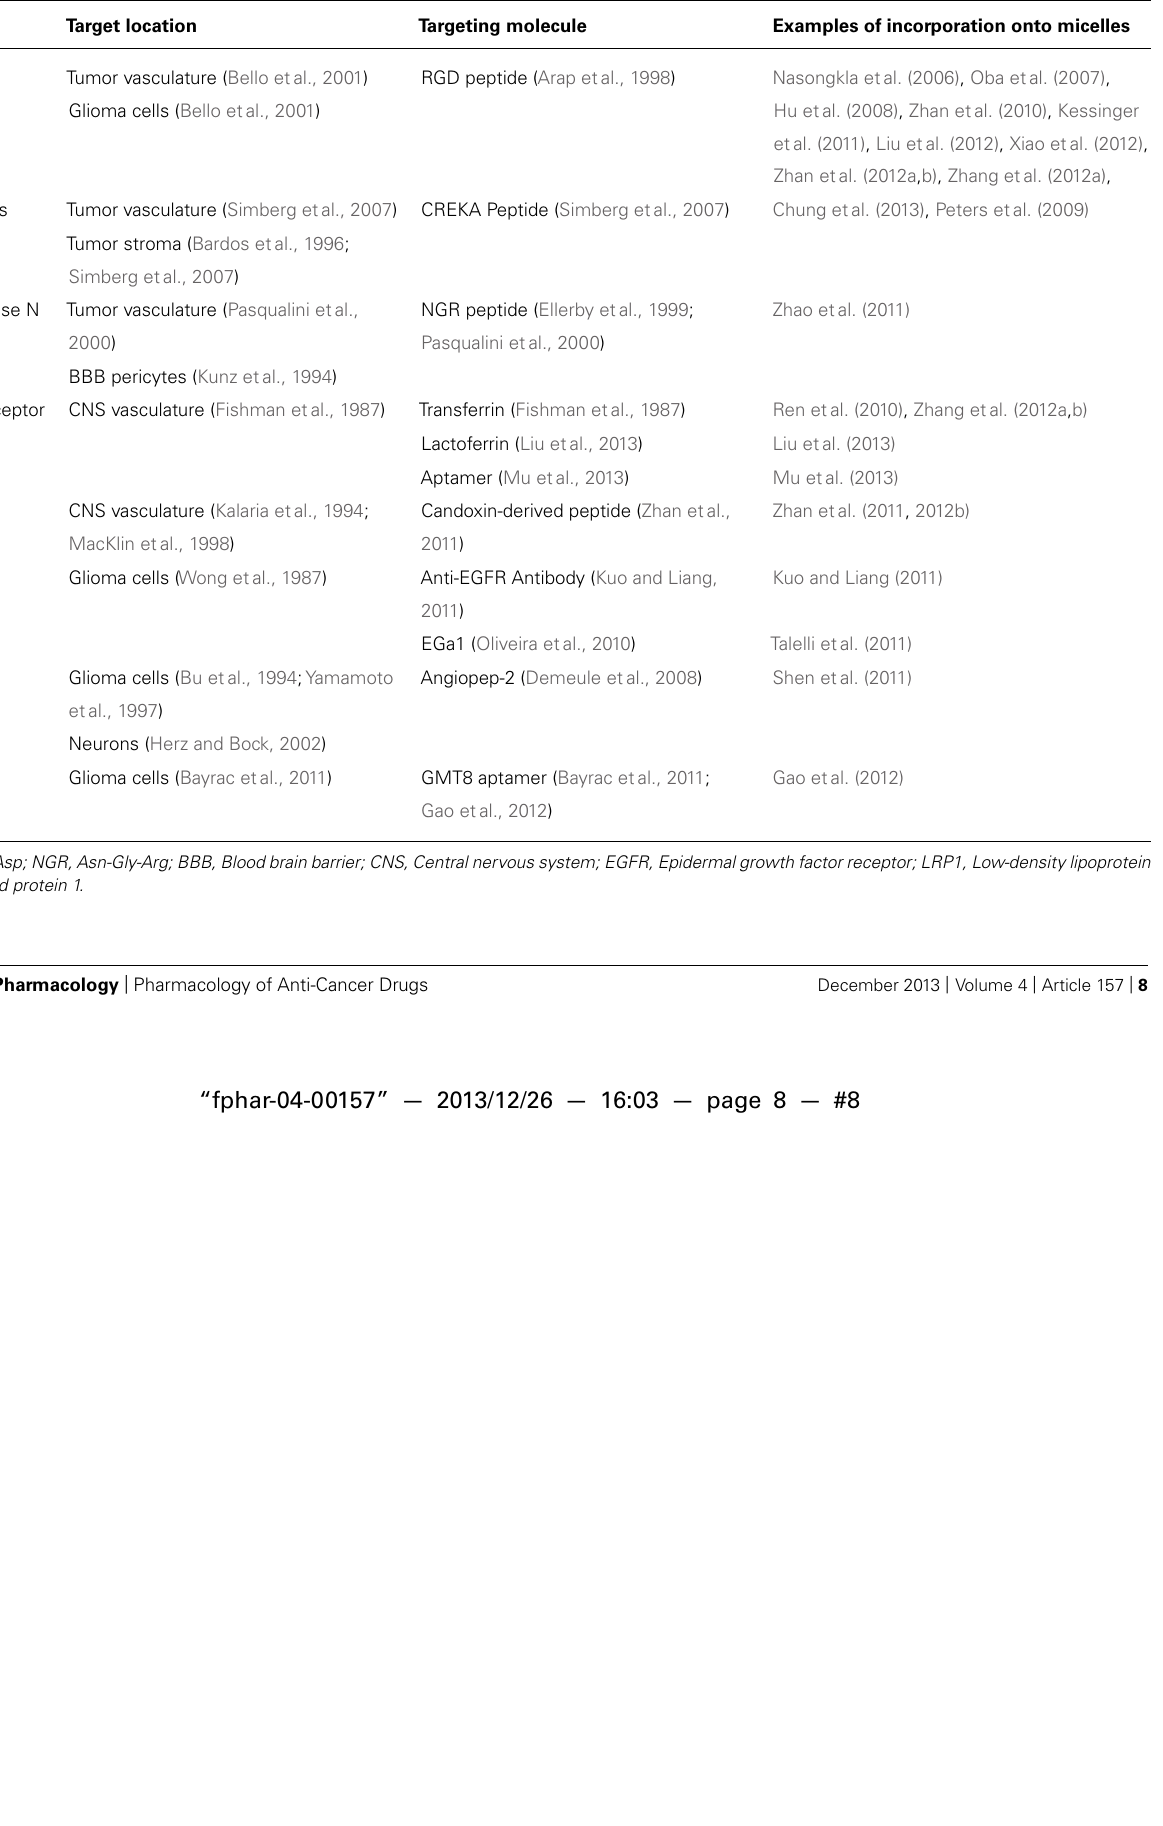
Table 2 |Targets and targeting moieties to enhance micelle specificity toward brain